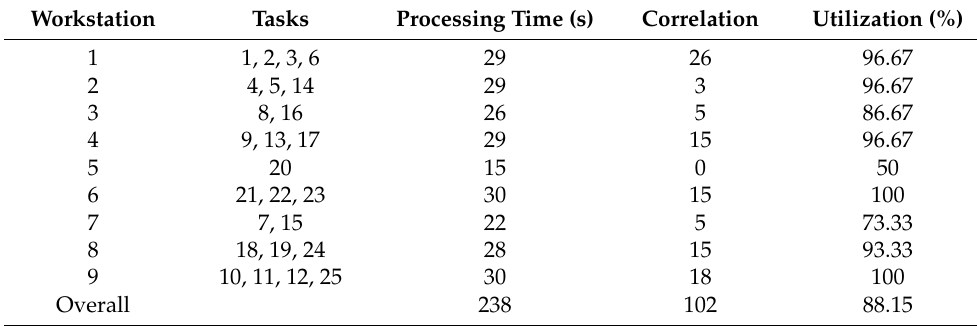
Table 3. Numerical results for disassembly of the case example.